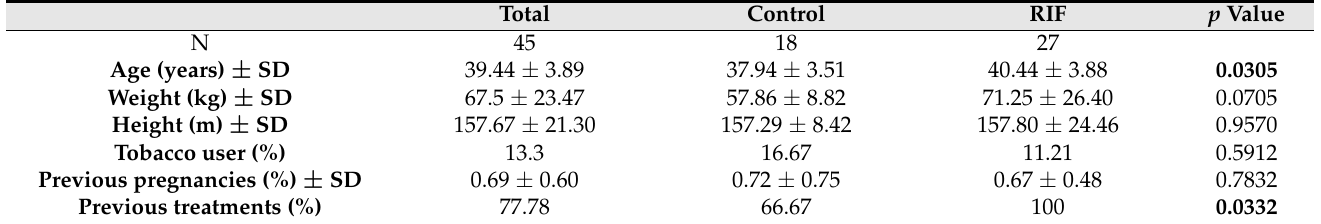
Table 1. Characteristics and clinical outcomes of study population. p values < 0.005 are shown in bold. Total Control